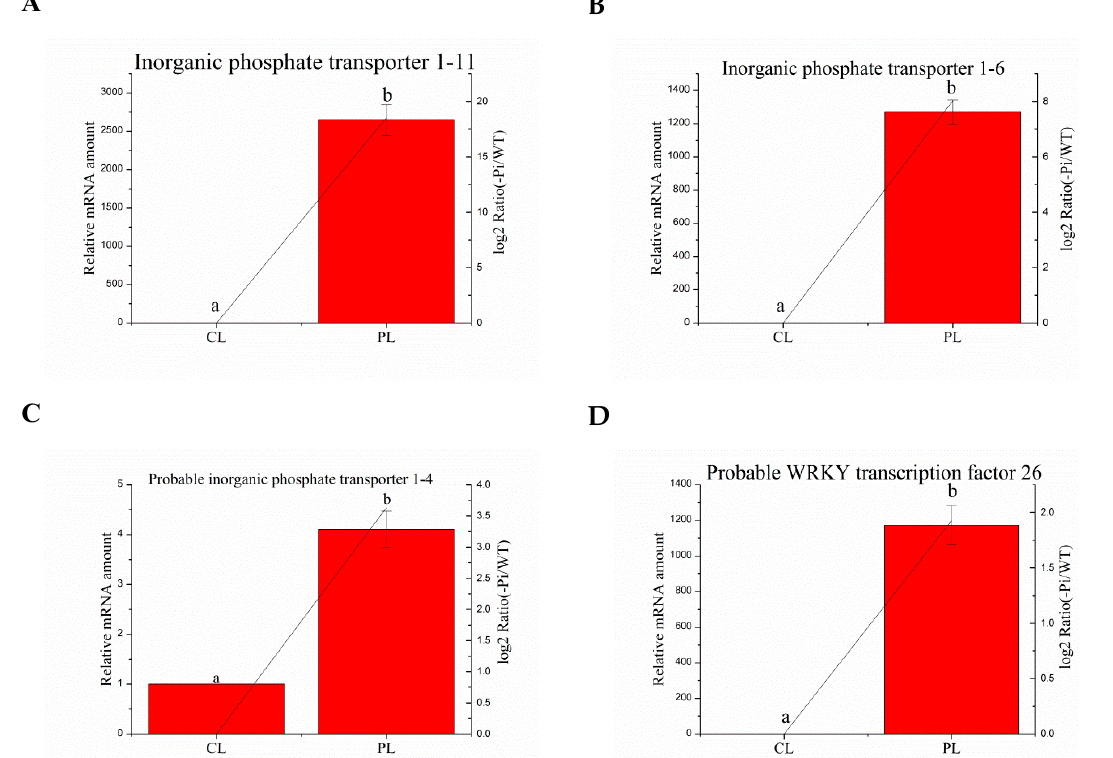
Figure 4. Relative expression of P deficit-induced genes in aboveground plant parts in WT and − P treatments was determined by quantitative RT-PCR analyses. Expression was normalized to that of actin . The transcript levels from the WT sample were set to 1. The red columns represent the expression levels determined by qRT-PCR (left axis), while the lines represent the gene expression levels determined by RNA-seq (right axis). The transcript abundances of genes encoding inorganic phosphate transporter 1–11 protein ( A ); norganic phosphate transporter 1–6 ( B ); probable inorganic phosphate transporter 1–4 ( C ), and probable WRKY transcription factor 26 ( D ) were determined and compared across the time course of phosphorus deficit stress. Data represent means ± SD of three replicates ( n = 3). Different lowercase letters above the columns indicate a significant difference at p ≤ 0.05 between the columns by T test using SPSS statistical software. Data in columns with the same letters showed no significant difference ( p > 0.05).